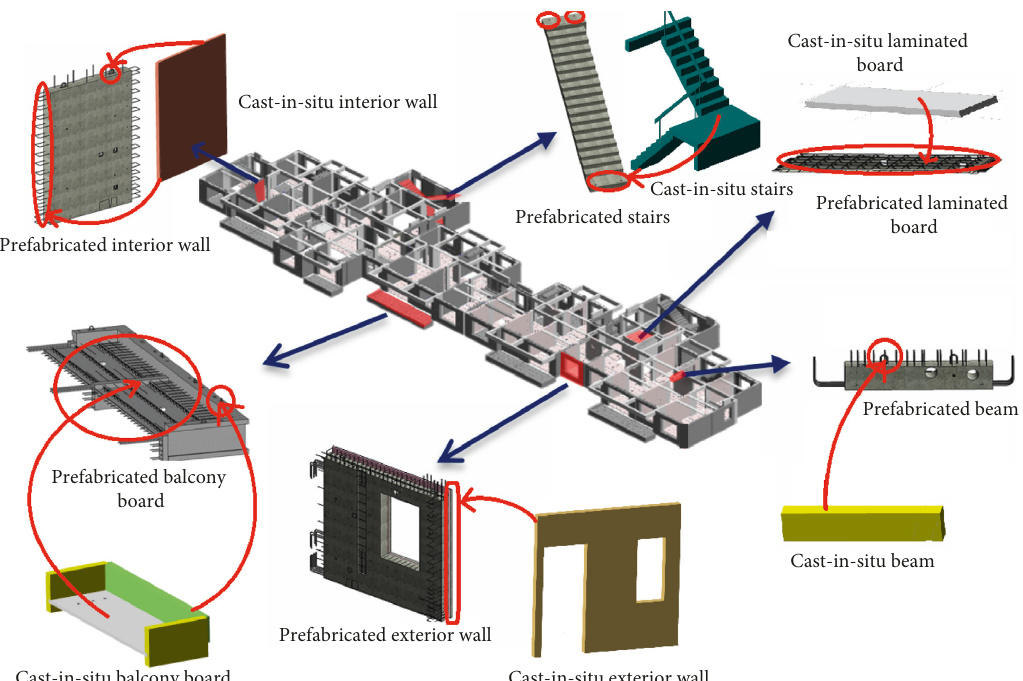
Figure 5: Transformation between prefabricated components and cast-in-situ components, developed by the